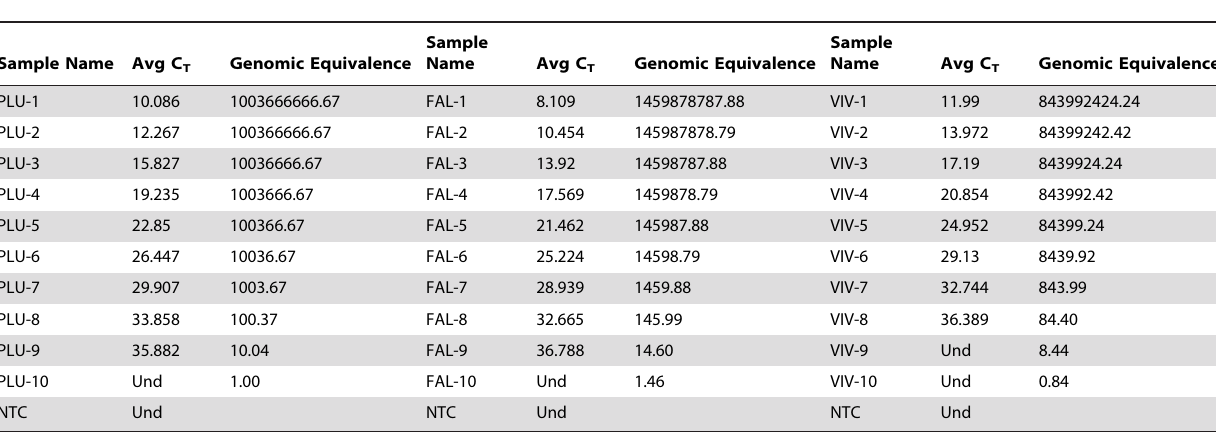
Table 4. Absolute qPCR CT values obtained vs. the genomic equivalence